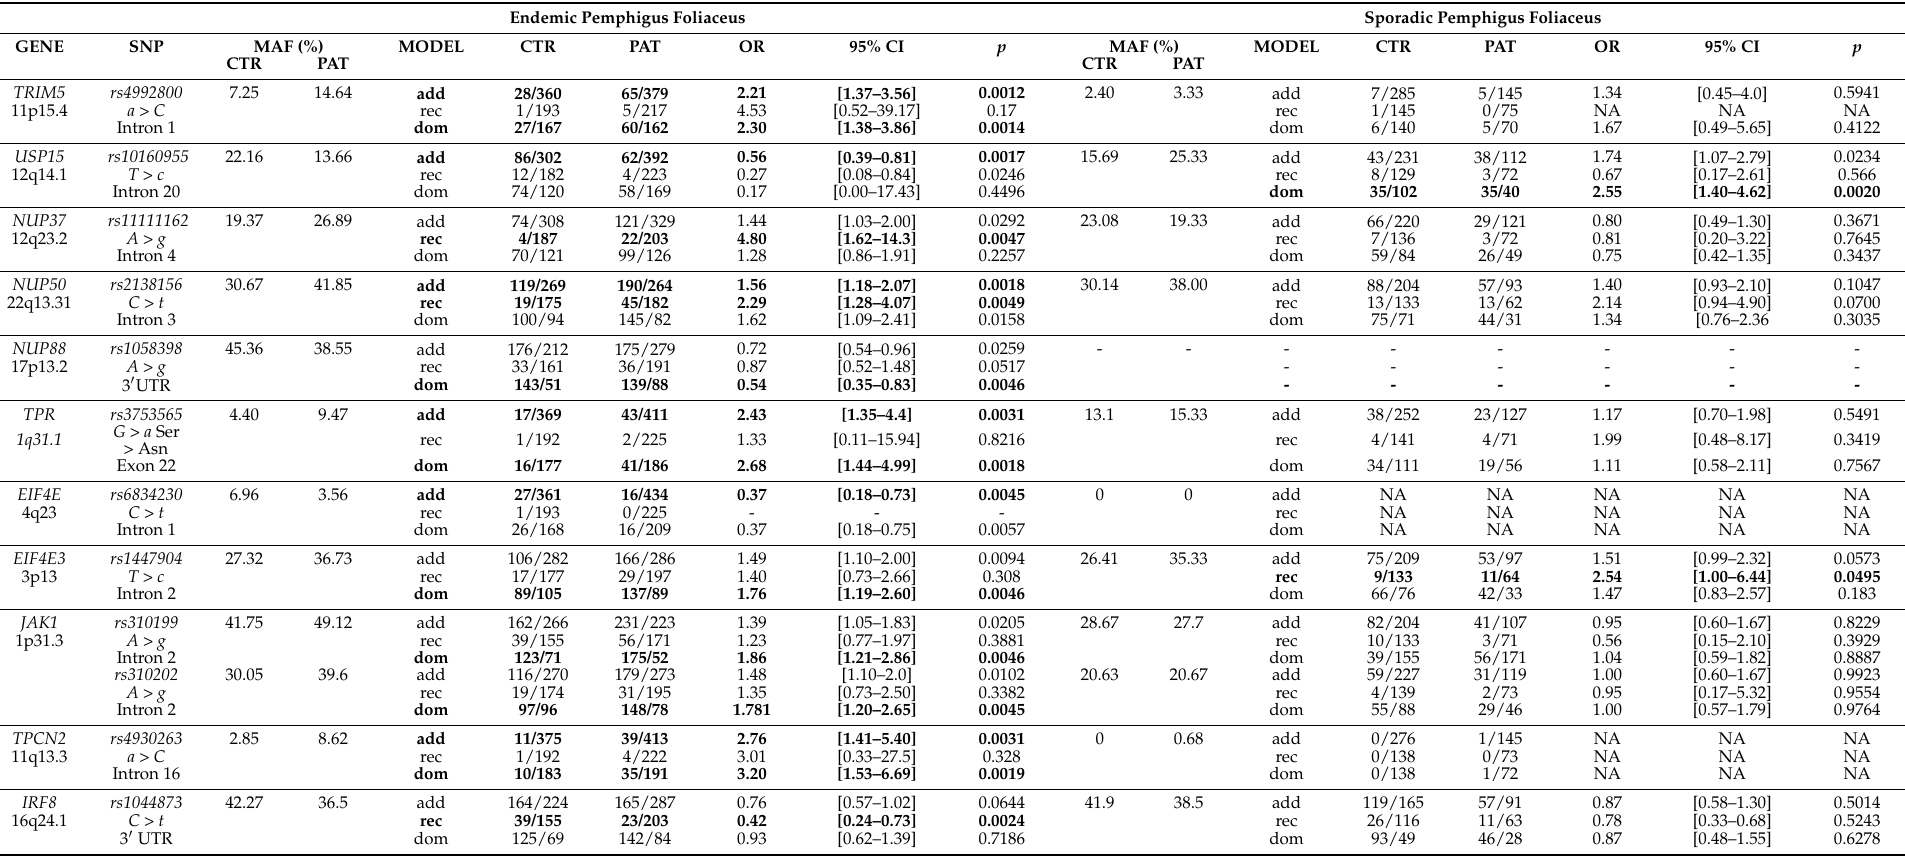
Table 1. Genetic variants associated with endemic pemphigus foliaceus and association analysis of the same variants in sporadic pemphigus foliaceus. Endemic Pemphigus Foliaceus Sporadic Pemphigus